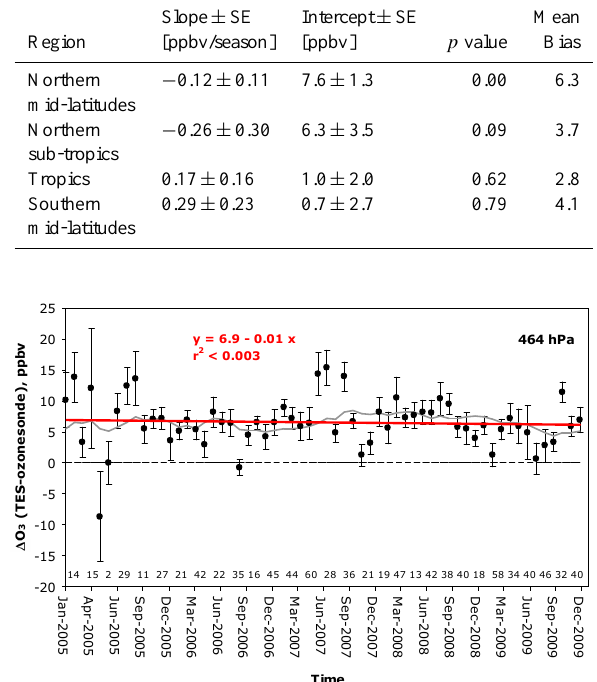
Table 3. Slope, intercept and R 2 for a reduced major axis re- gression fit of sonde O 3 ( y ) as a function of TES O 3 ( x ) (O 3 , sonde =slope x O 3 , TES +intercept) for different latitude zone at the 464hPa pressure level for the period 2005–2010. The fitted slope is indicative of the multiplicative component of the TES bias, and the intercept of the additive component. The bias is the mean of y − x .